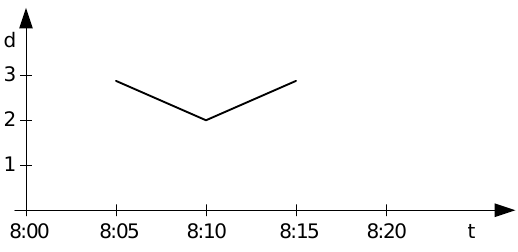
Figure 4. Distance between the trajectories of the two trucks in Figure 3 represented as a temporal(real)